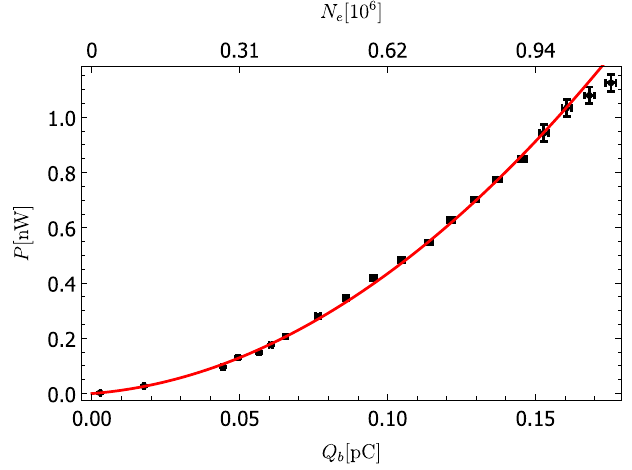
FIG. 9. SPR power P for different bunch charges Q P as the square of Q effect is detected.